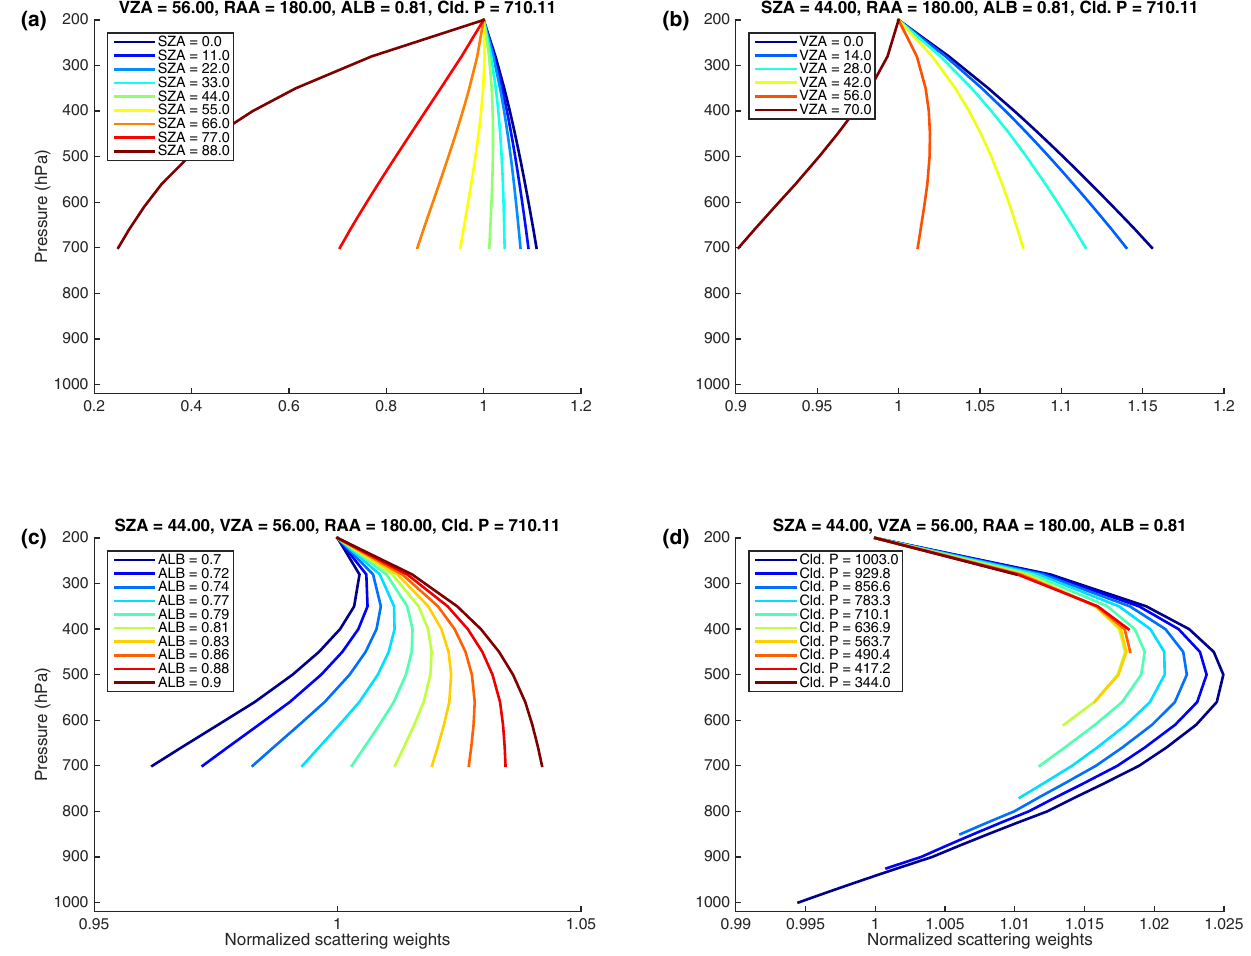
Figure 4. As in Fig. 3, but for cloudy conditions. Note that the x axis limits are different from Fig. 3 and each